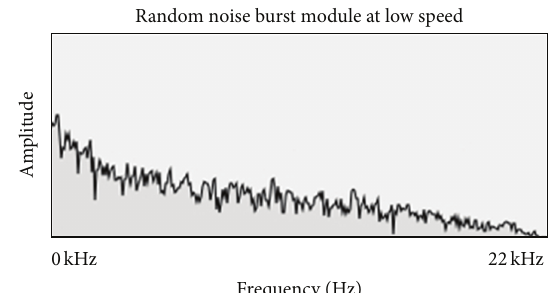
Figure 10: Spectrogram showing a snapshot of the random-noise bursts at low